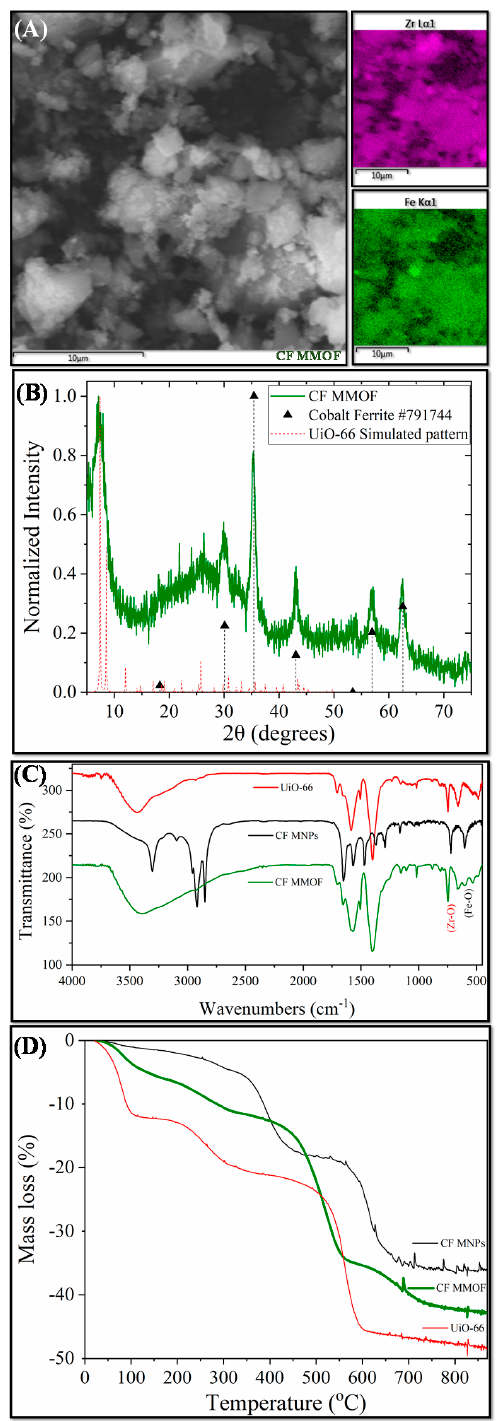
Figure 1. ( A ) SEM image; ( B ) XRD measurement; ( C ) FTIR spectrum; and ( D ) TGA of CF MMOF.